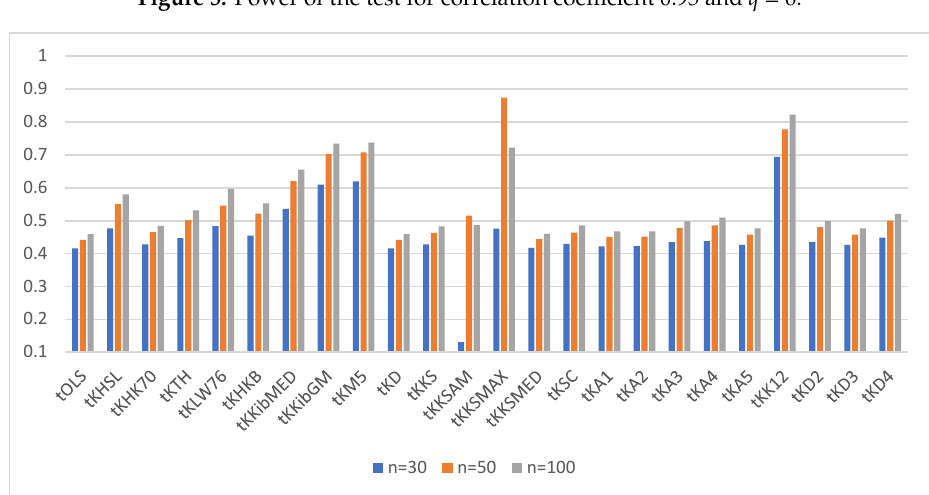
Figure 6. Power of the test for correlation coefficient 0.95 and q = 10.